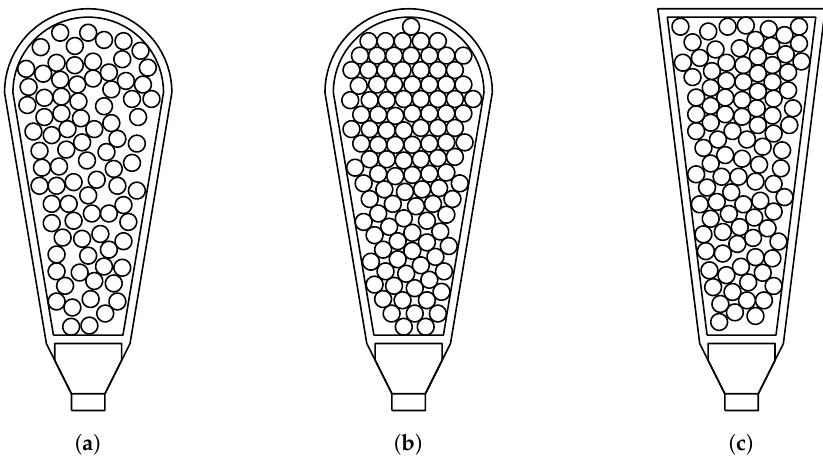
Figure 9. Examples of filled slots. ( a ) S d = 0, ( b ) S d = 1, ( c ) L-type